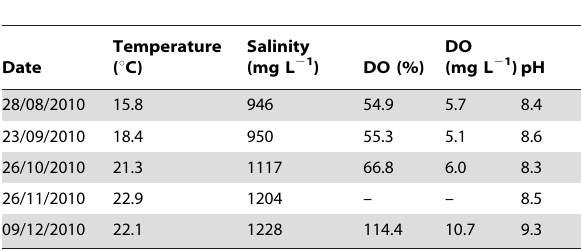
Table 1. Physical and chemical